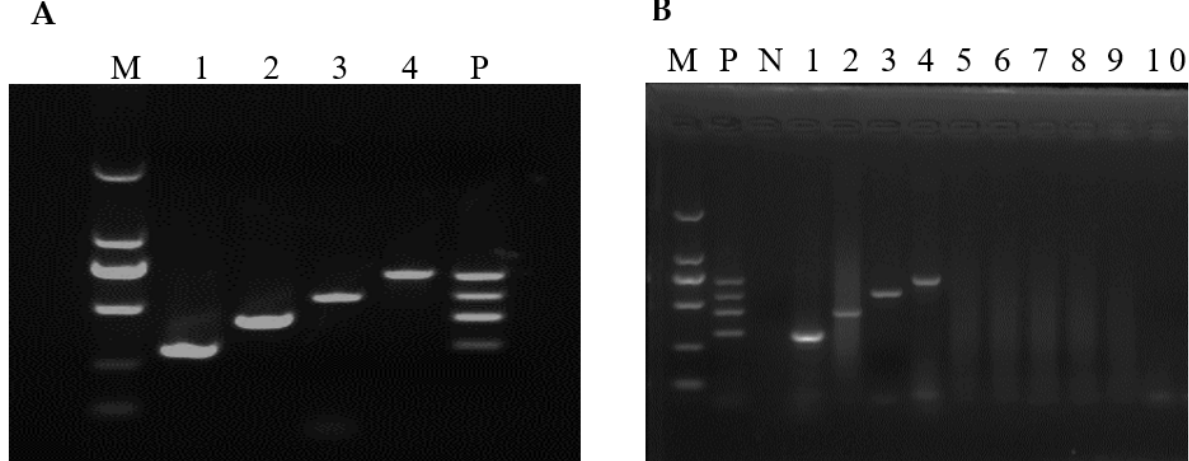
Figure 1. mRT-PCR optimization and assay specificity. M: 2000 bp marker, 1: SaV, 2: EMCV, 3: RVA and 4: AstV, P: standard plasmid template mix containing SaV, EMCV, RVA and AstV fragments.